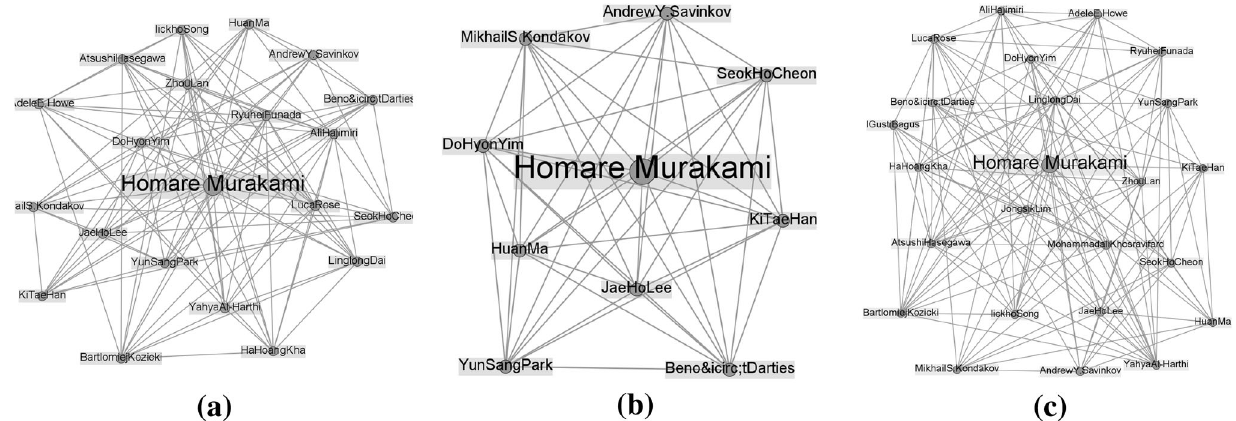
Fig. 8 Query node ‘‘Homare Murakami’’ in different models. a (9-core with 21 nodes,105 edges). b (9-truss with 10 nodes,45 edges). c (9-core- truss 24 nodes,126 edges)